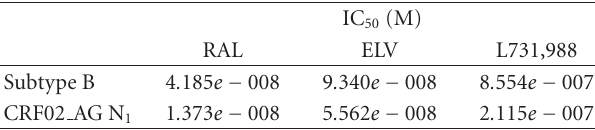
Table 3: IC 50 of 3 INSTIs against recombinant HIV-1 B IN and CRF02 AG